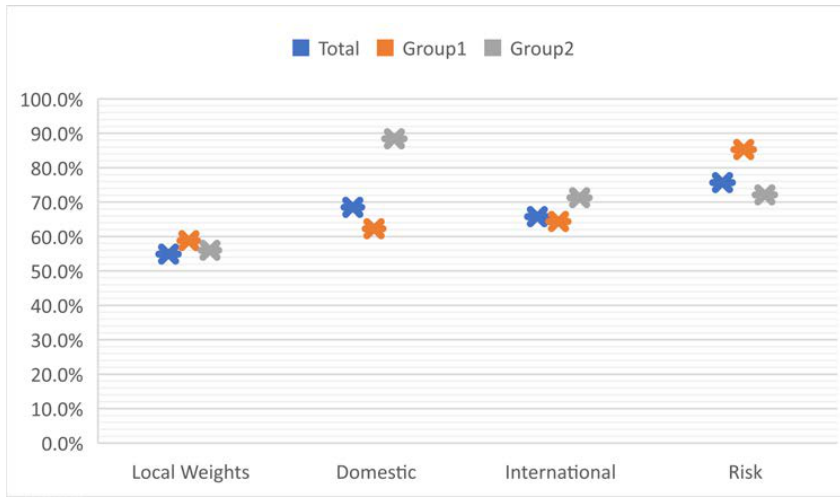
Figure 13. Consensus measure.